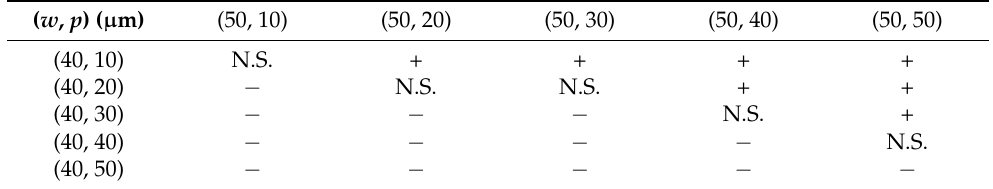
Table 3. Statistical significance in dry perception between samples with w values of 40 and 50 µ m. N.S. means not significant.